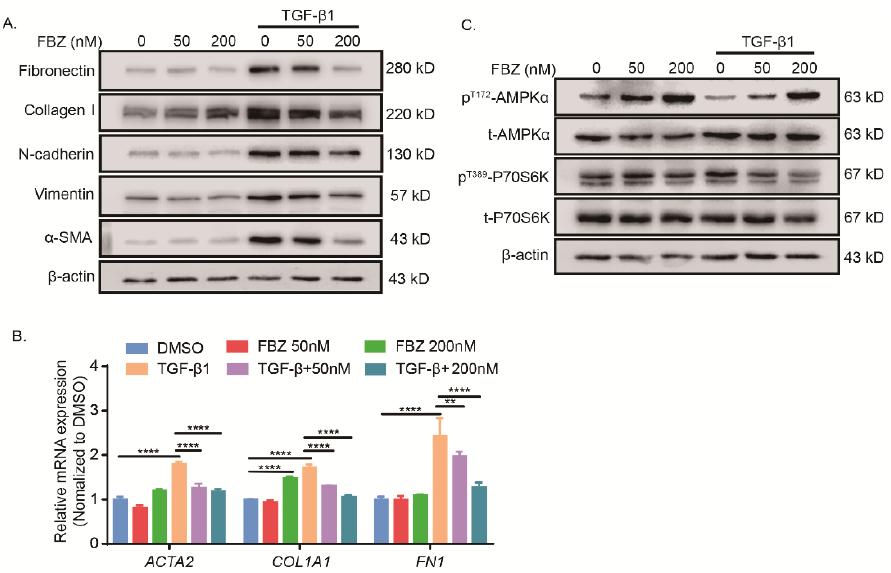
Figure 5. Fenbendazole inhibited TGF- β 1-induced fibroblast-to-myofibroblast transition and collagen formation through AMPK activation. ( A ) IMR-90 cells stimulated with or without TGF- β 1 for 24 h followed by FBZ treatment (0 nM, 50 nM, or 200 nM) for an additional 24 h. Expression of fibronectin, collagen I, N-cadherin, vimentin, and a-SMA were determined by immunoblot; β -actin used as the loading control. ( B ) RT-qPCR analysis of ACTA2 , COL1A1 , and FN1 mRNA expression in cell lysate treated as ( C ); ACTB used as the internal control ( n = 3, mean + SEM). ( C ) IMR-90 cells treated as ( C ). Phosphorylated (Thr172) AMPK α 1/2, total AMPK α 1/2, phosphorylated (Thr389) P70S6K, and total P70S6K in cell lysate were determined by immunoblot; β -actin was used as the loading control. ** p < 0.01, and **** p <